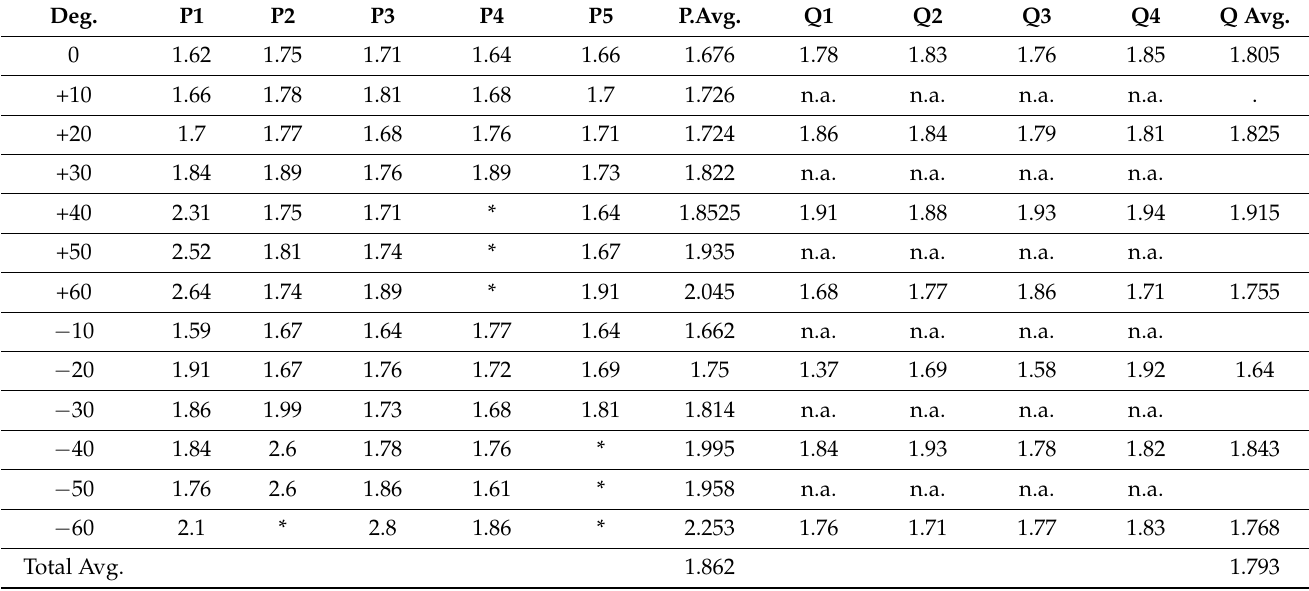
Table 3. Deviations from markers on head phantoms in mm with masked observer.